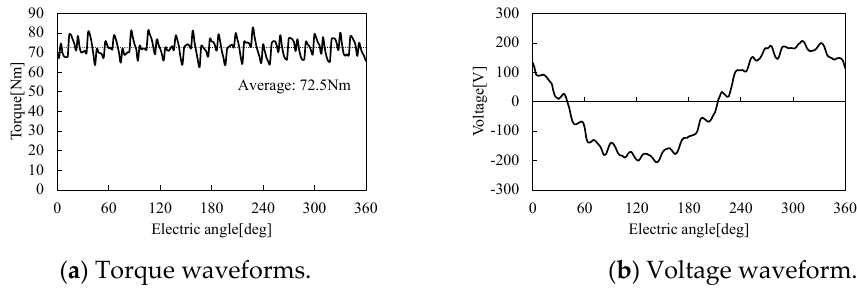
( a ) Torque waveforms. ( b ) Voltage waveform. Figure 18. Rotation speed of 11,500 min − 1 , input current of 356 Arms, and slip of 0.16.